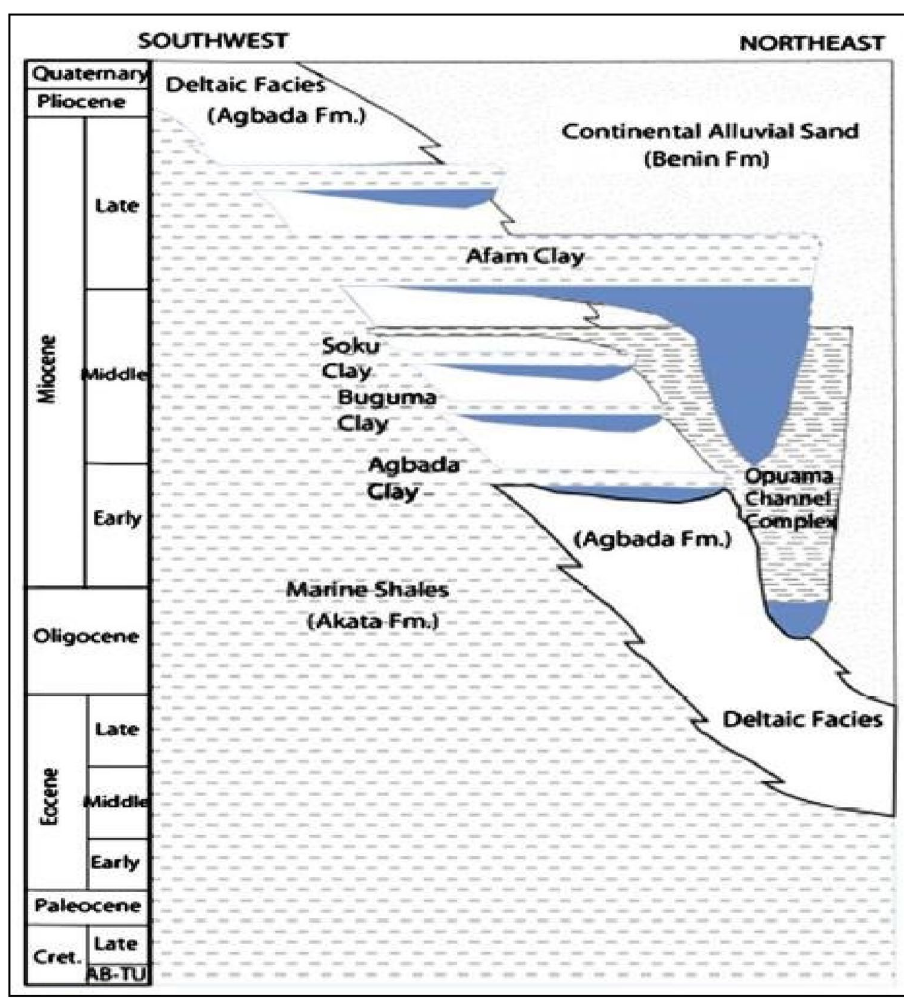
Fig. 3 Stratigraphic column of the Niger Delta Basin. (Redrawn from Doust and Omatsola